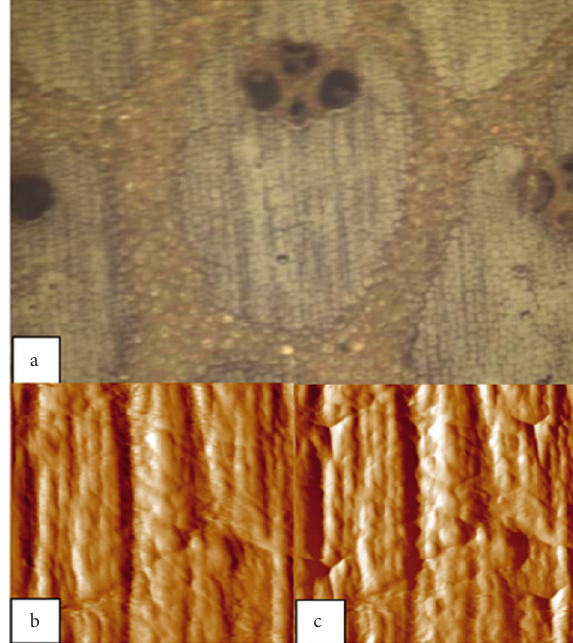
Figure 13: Parenchyma cell wall from (a) microscopic level, (b) AFM before indentation, and (c) AFM after